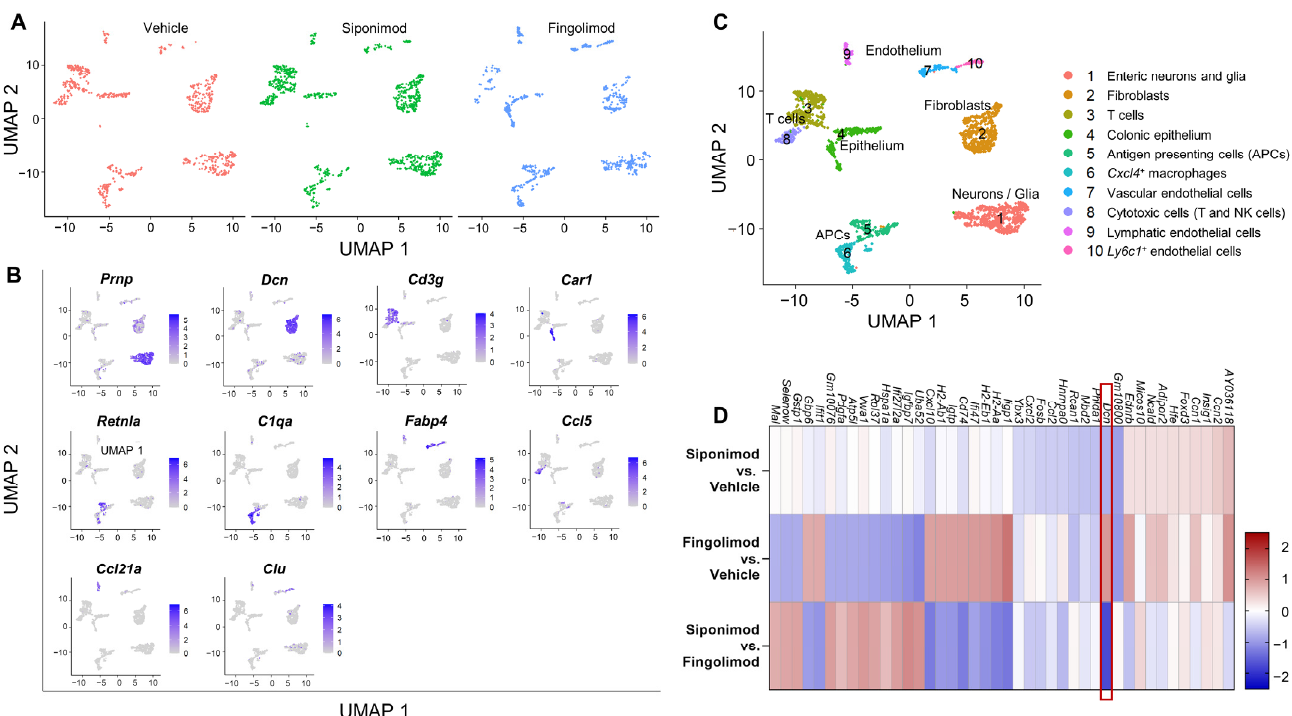
Figure 6. Single-cell RNA sequencing of the longitudinal muscle layer with attached myenteric plexus in chronic EAE mice. LMMP was digested mechanically and enzymatically, and mRNA from single cell suspensions was analyzed using scRNA-seq. ( A ) UMAP clustering with a resolution of 0.2 revealed 10 different clusters evenly detected in all treatment groups. ( B ) Top genes expressed by each cluster. ( C ) Clusters were classified according to marker genes. ( D ) Heatmap of differentially expressed mRNA between treatment groups of cluster 1. The heatmap shows the top 10 genes of each comparison with highest and lowest logFC values. The red box highlights the only gene with a logFC >|1.5|. LMMP = longitudinal muscle layer with attached myenteric plexus, scRNA-seq = single-cell RNA sequencing, logFC = log(fold change), UMAP = uniform manifold approximation and projection.